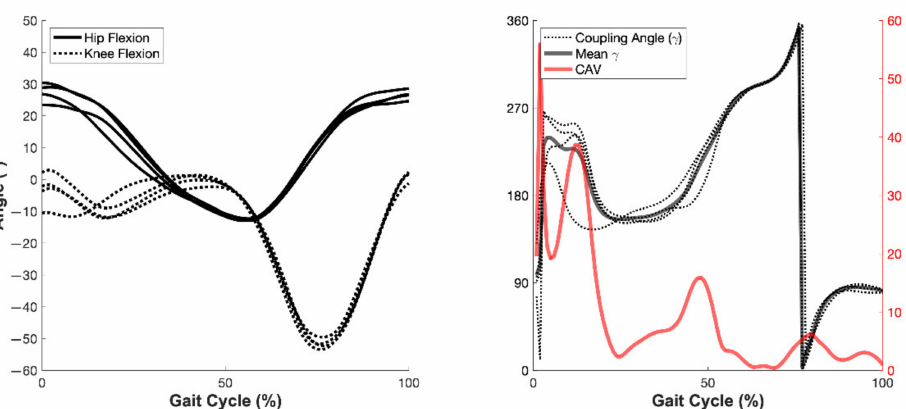
Figure 2. An illustration of the coupling-angle-variability (CAV) calculation process for the hip- flexion/knee-flexion joint coupling for a representative participant. The left figure shows hip and knee flexions across four gait trials; the right figure shows the coupling angle ( γ ) for the trials, the mean γ , and the